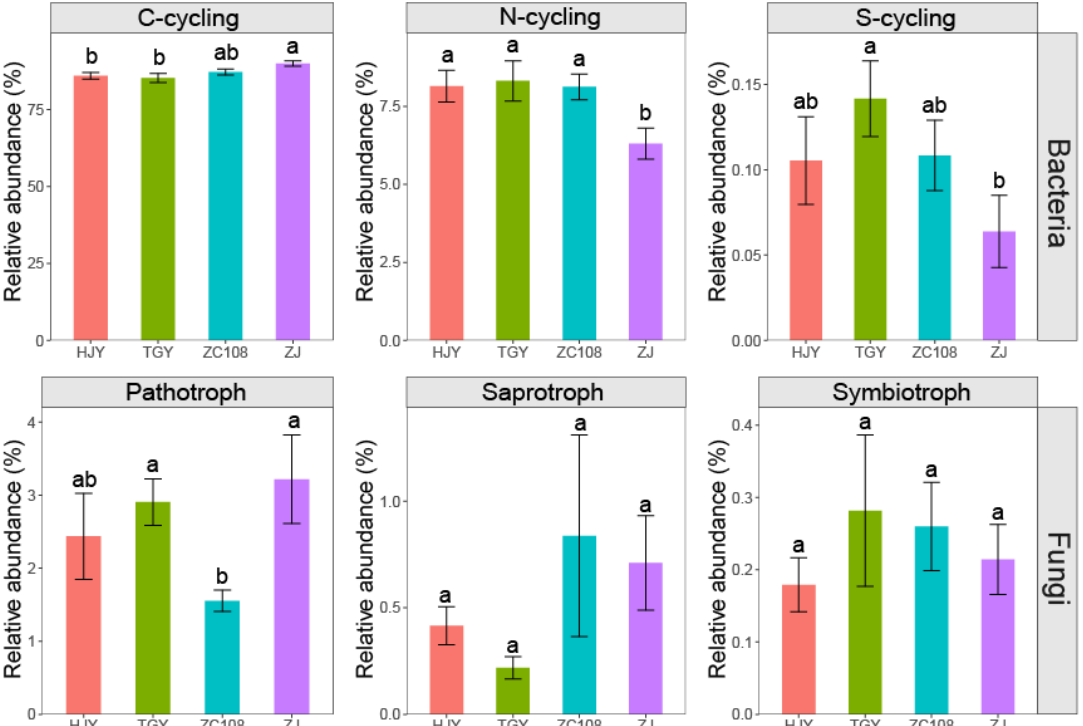
Figure 7. The major functional profiles of bacterial (top panel; C, N, and S cycle by FAPROTAX) and fungal (bottom panel; Pathotroph, Saprotroph, and Symbiotroph by FUNGuild) communities. The data shown are mean ± standard error (SE; n = 6). Different lowercase letters above the bars indicate significant differences ( p < 0.05). HJY, Huangjinya, TGY, Tieguanyin, ZC108, Zhongcha108, ZJ, Zijuan.